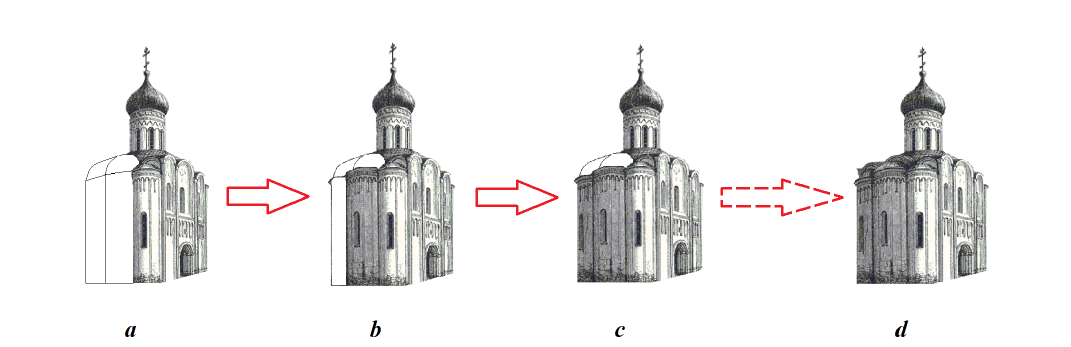
Figure 4: Automatical object reconstruction after automaton